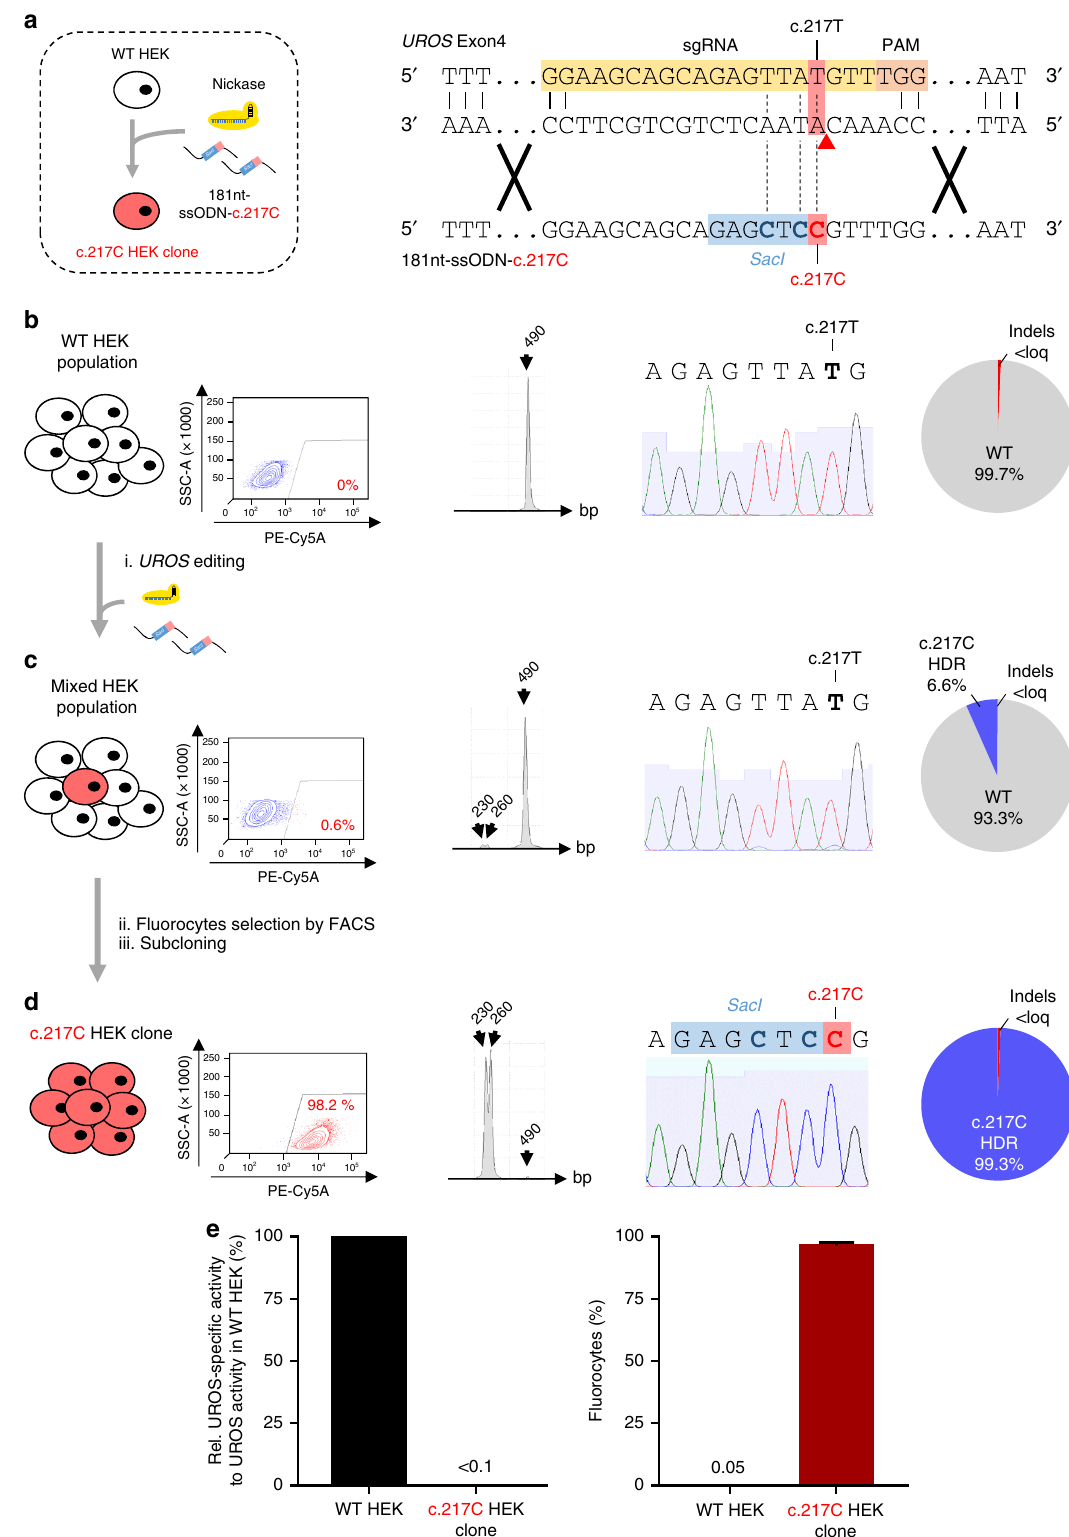
highlighted, after nickase and ssODN template transfection, the percentage of cells with 2 O/3 G signal was signi fi cantly lower than with nuclease ssODN (5 and 17% respectively, Fig. 3a, p < 0.01) and similar to non-transfected cells. Sub-telomeric 10q FISH analysis of transfected cells with nickase